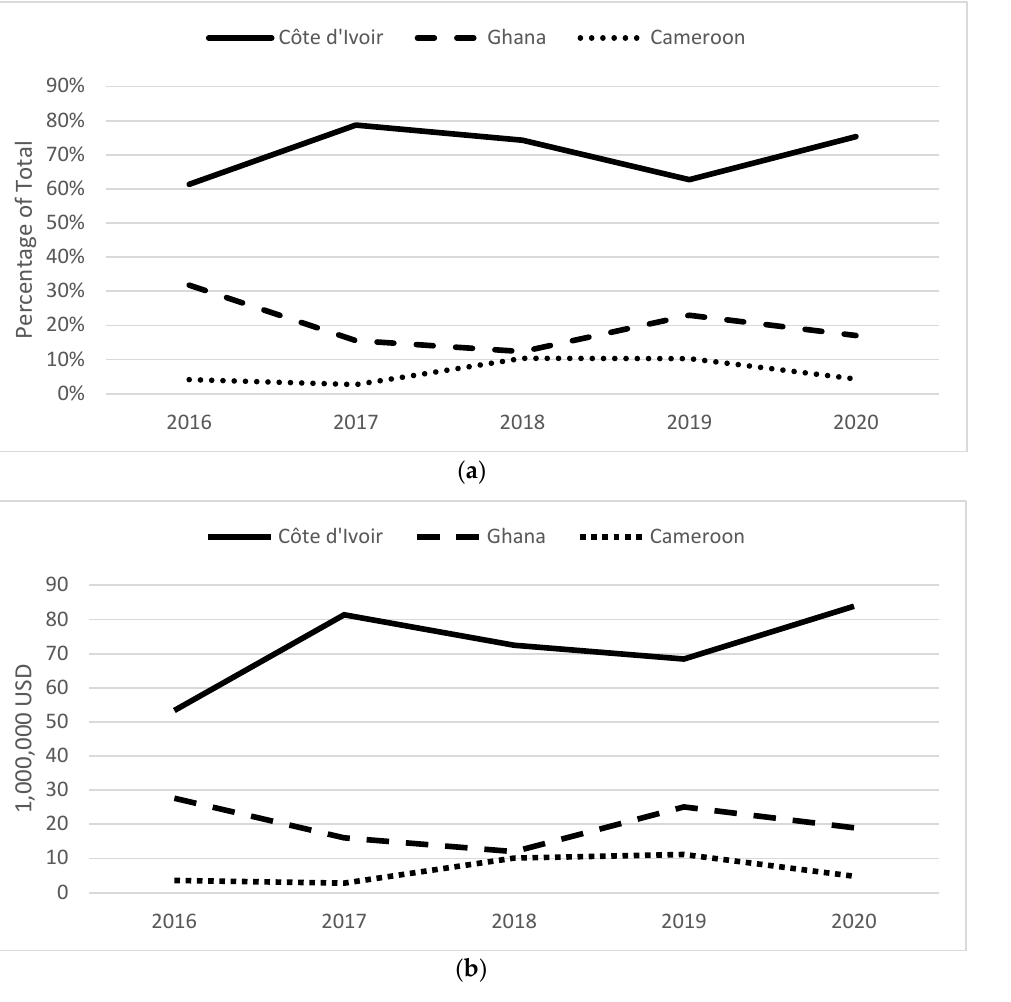
Figure 1. Turkish Imports of Cocoa Beans by Country of Origin. Panel ( a ) percentage of total; Panel ( b ) real value (USD 1,000,000).